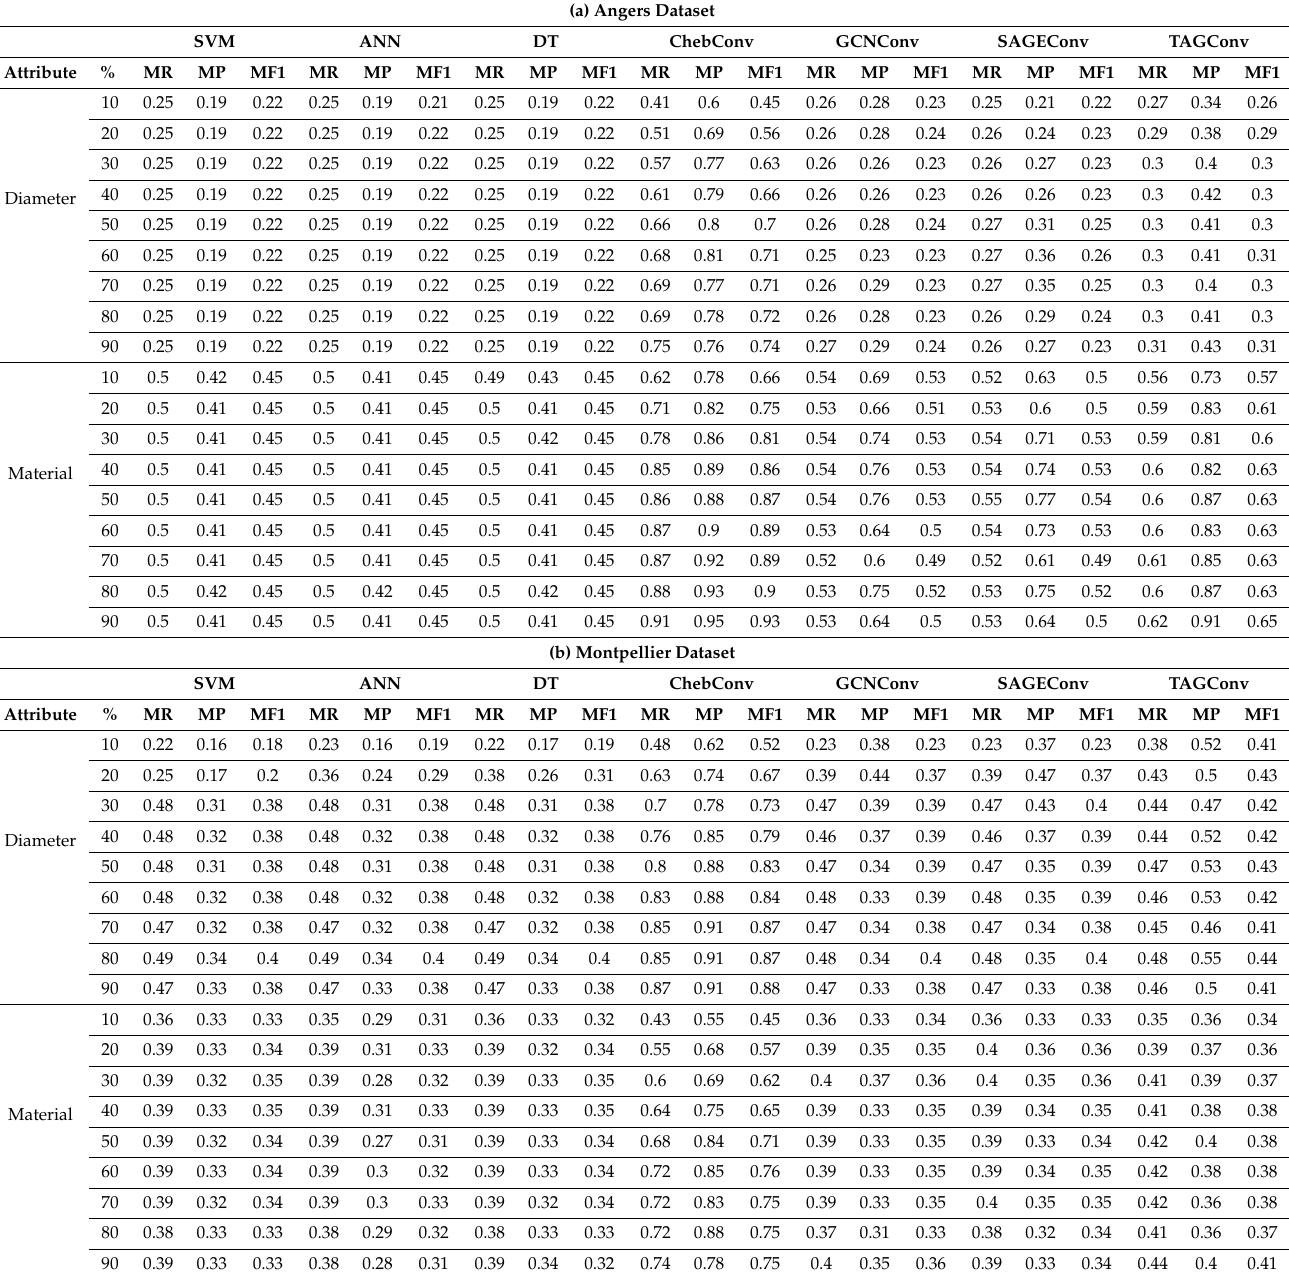
Table 1. Configuration 1. Results obtained for Angers and Montpellier dataset by the seven models in terms of Macro-Recall (MR), Macro-Precision (MP), and Macro-F1 (MF1) scores, for the two classes and with different percentages of the dataset used for